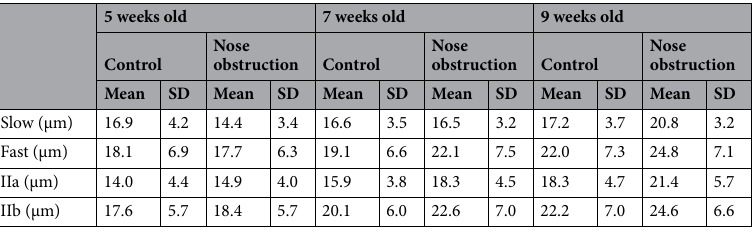
Table 4. Diameter values of genioglossus muscle fibers. Data presented as mean ± standard deviation (SD). Slow slow type muscle fiber, Fast fast type muscle fiber, IIa fast-twitch IIa type muscle fiber, IIb fast-twitch IIb type muscle